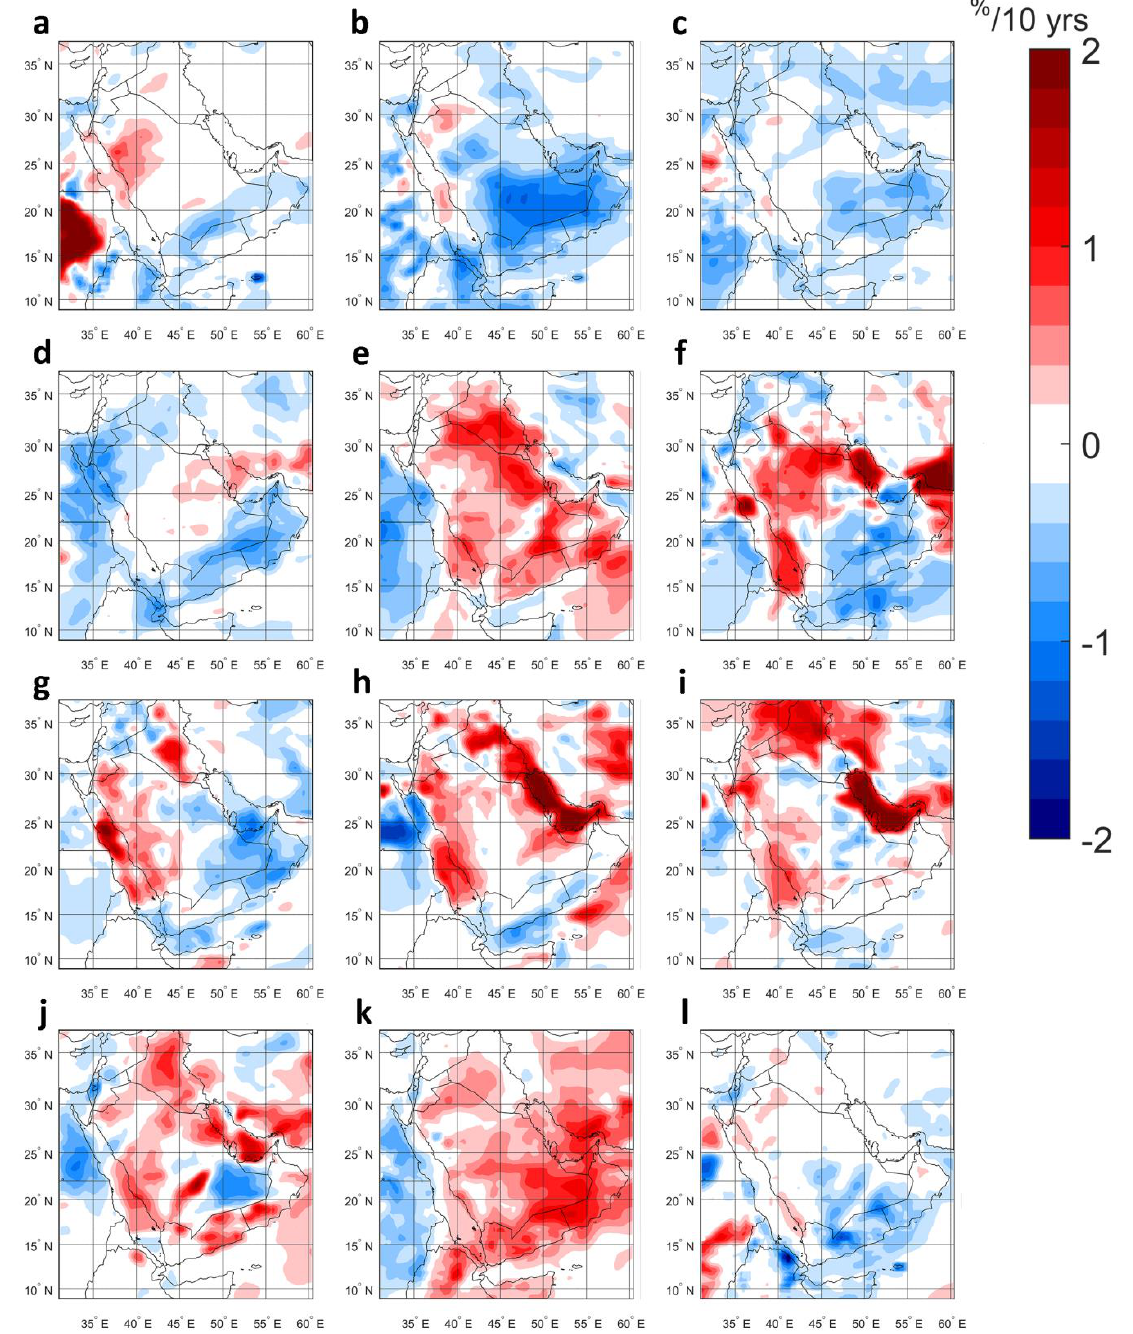
Figure 11. Monthly accumulated precipitation (modeled) change per 10 years for ( a ) January, ( b ) February, ( c ) March, ( d ) April, ( e ) May, ( f ) June, ( g ) July, ( h ) August, ( i ) September, ( j ) October, ( k ) November and ( l )